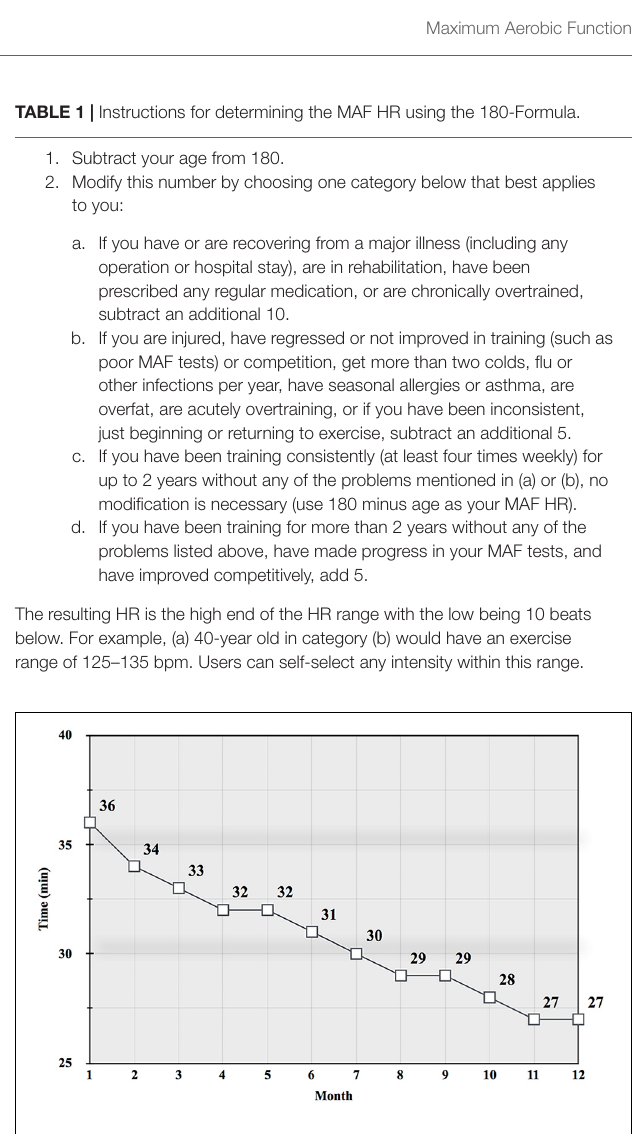
FIGURE 1 | Graph from a 35 year-old experienced male runner’s monthly MAF test results (total time in min, rounded) on a flat 5 km road course during a 12-month aerobic-only (running at or below the MAF HR) training period (Maffetone,